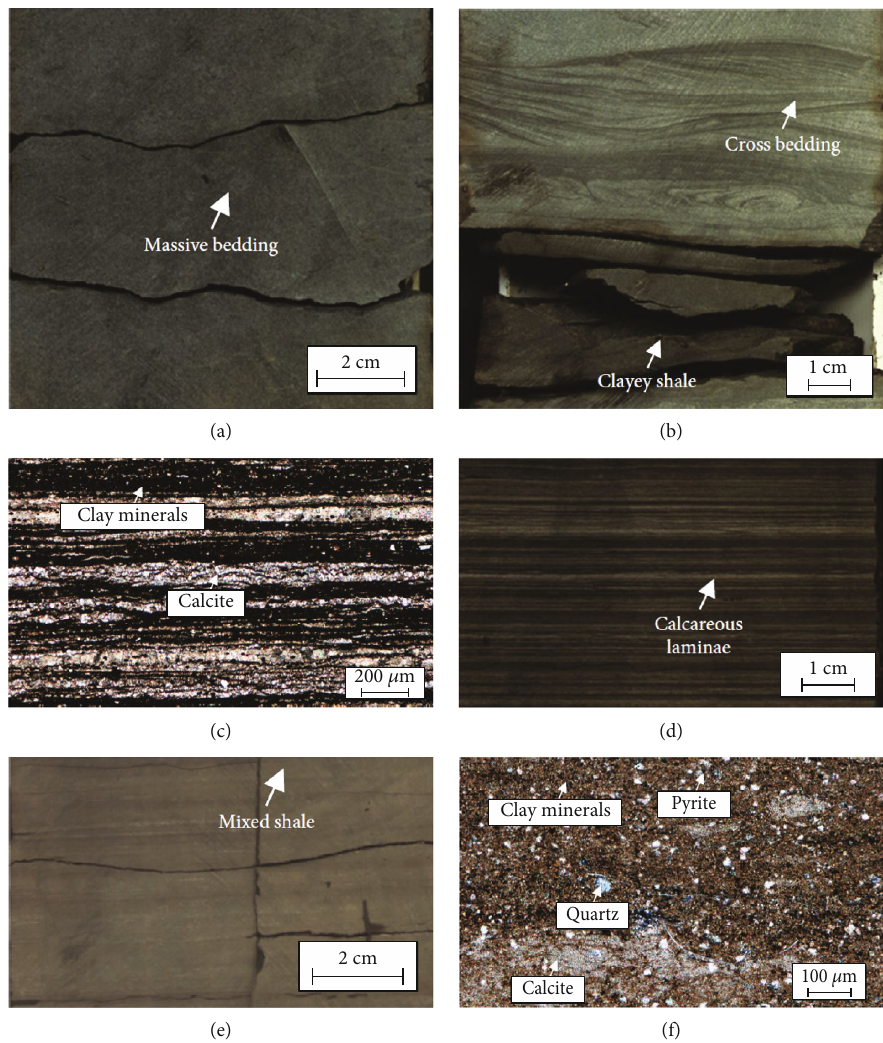
Figure 3: Characteristics of main lithofacies in the Es4u member in the Dongying Depression. (a) Massive bedding developed in the siltstone, 3439m. (b) Gray clayey shale and cross-bedding developed in the siltstone, 3444 m. (c) Calcareous shale: light laminae comprise calcite; dark laminae are composed of clay minerals, 3397.5m. (d) Dark gray calcareous shale developing dark and light laminae, 3397.5m. (e) Gray mixed shale developing laminae, 3331.5m. (f) Mixed shale composed of calcite, quartz, clay minerals, and pyrite, 3331.5m.